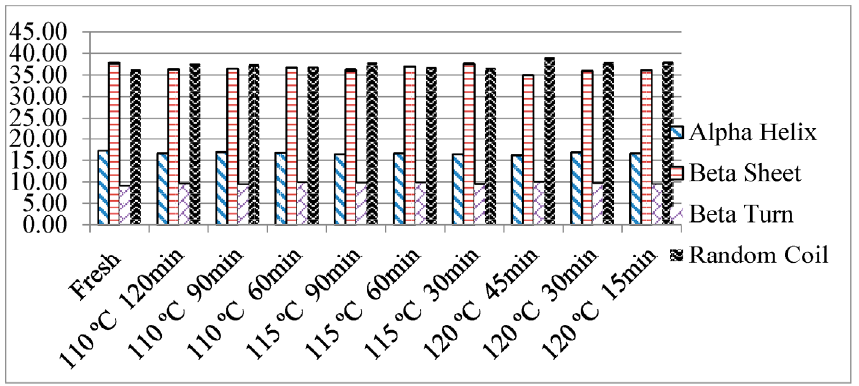
Figure 5. Percentage content of secondary structure of fresh, unprocessed and thermally treated soy slurry samples.